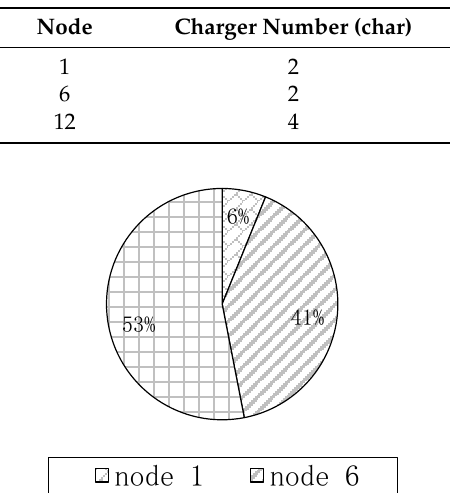
Table 18. Charging station construction program.